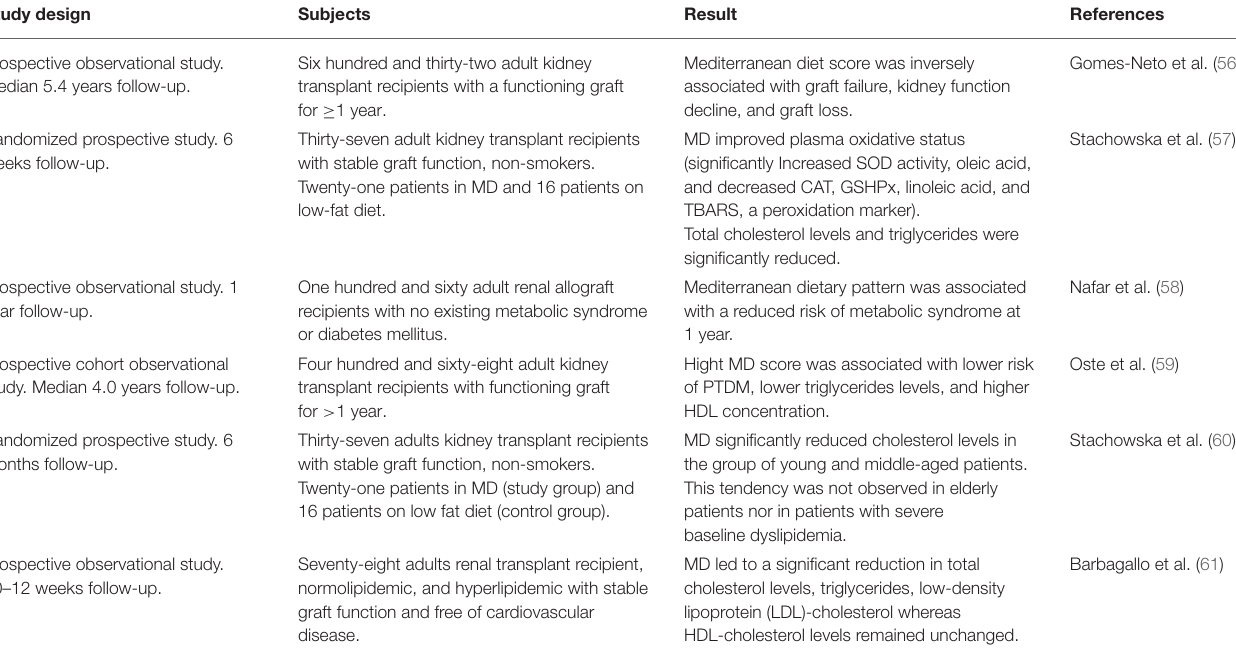
TABLE 3 | Overview of prospective clinical studies on the effect of Mediterranean diet in kidney transplant